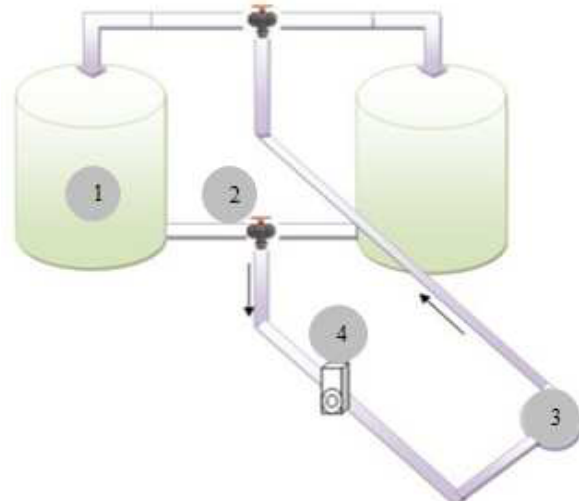
Figure 1. Schematic representation of disinfection pilot: (1) Tank, (2) three-way tap, (3) pump, (4) hydropad device Water samples were collected from the tap water from School of Public Health. A particular amount